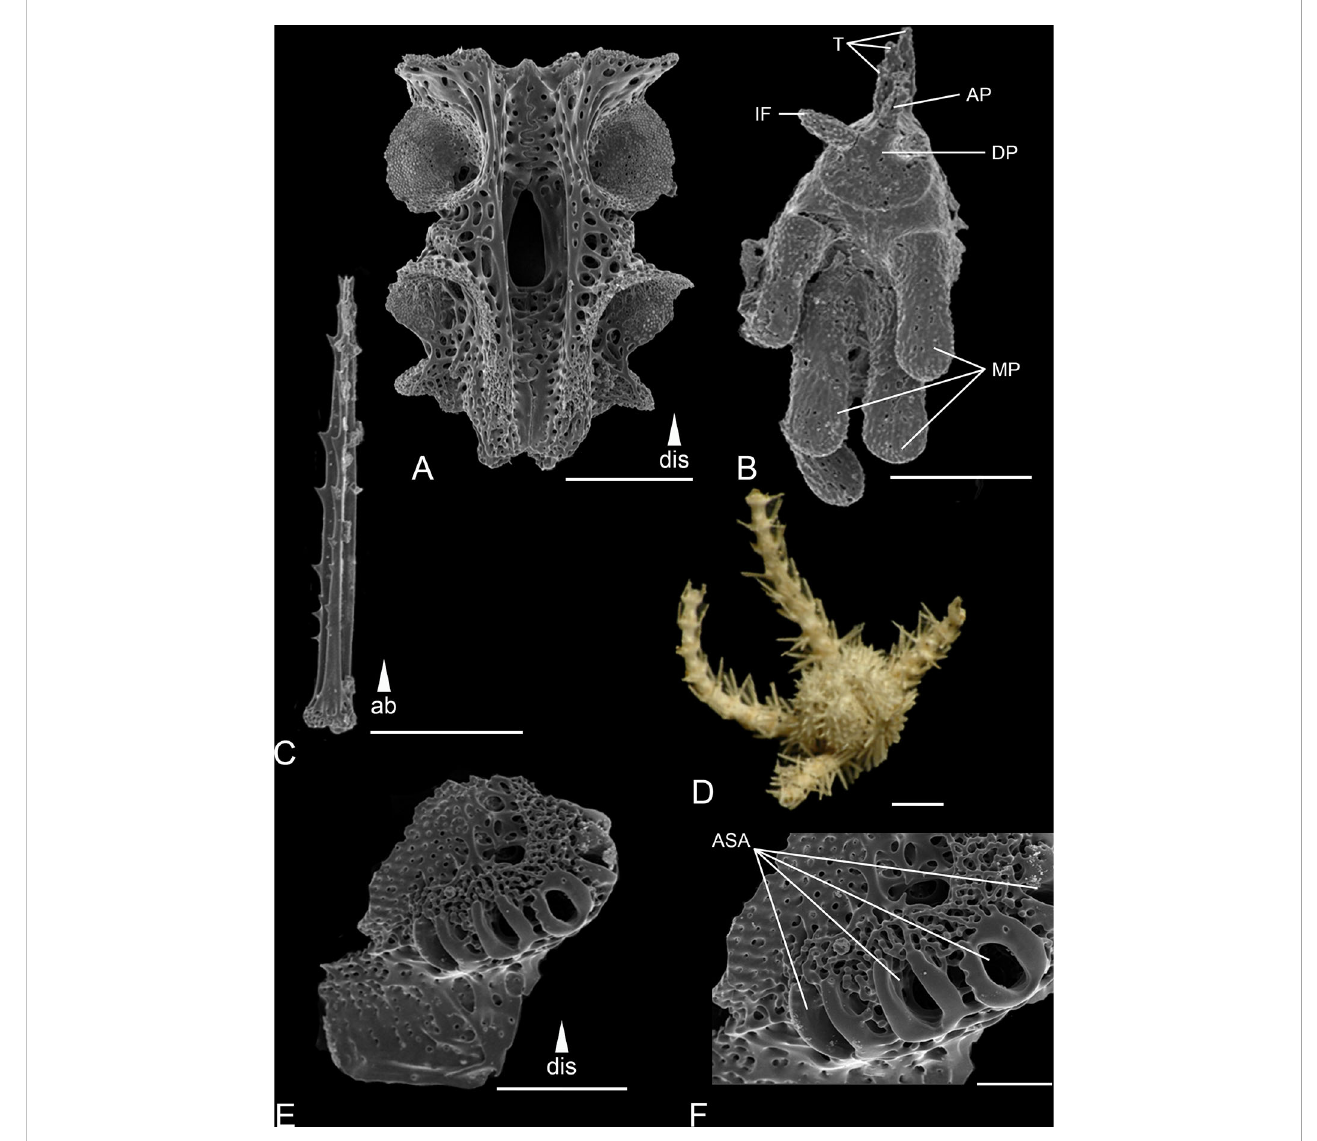
FIGURE 5 Scanning electron microscope images of the ossicles from Ophiotholia montana . (A) : Arm vertebrae (ventral); (B) : Jaw; (C) : Arm spine; (D) : Habitus; (E) : Lateral arm plate; (F) : Close up lateral arm plate. Scales: 30 µm (C) ; 80 µm (F) ; 200 µm (A, E) ; 400 µm (B) ; 1 mm (D) . ab, abradial; AP, apical papillae; ASA, arm spine articulation; DP, dental plate; dis, distal; IF, infradental papillae; MP, mouth papillae; T,